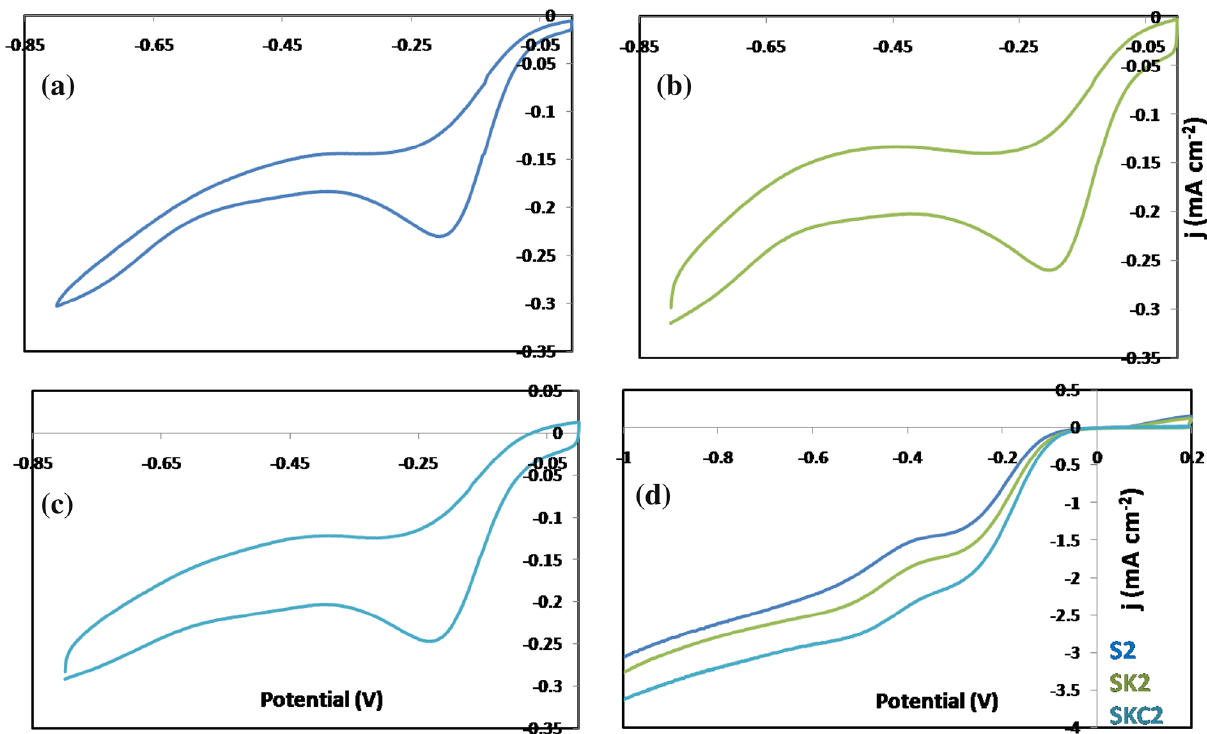
Fig. 6 a – c Cyclic voltammograms of the samples S2, SK2, and SKC2. d LSV plots for ORR in an O rate of 10 mVs −1 . The rotation rate is 1600